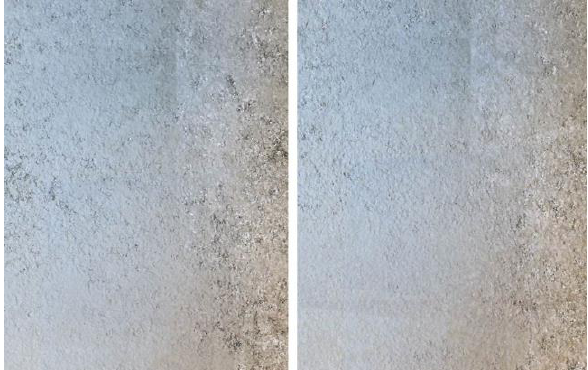
Figure 4. Pointcloud of the white wall (normal lens) before (left) and after (right) the post-processing on Photoshop Regarding the photos taken with the fisheye, 47 images were enough to cover the extension of the entire south wall. All the photos were aligned at the first attempt (the alignment was facilitated thanks to the width of the field of view captured by the lens). In this first case, however, the resulting point cloud and mesh were characterized by a high level of noise and the texture obtained was not very detailed due to the fisheye radial blur. To solve this problem, two solutions were attempted: the